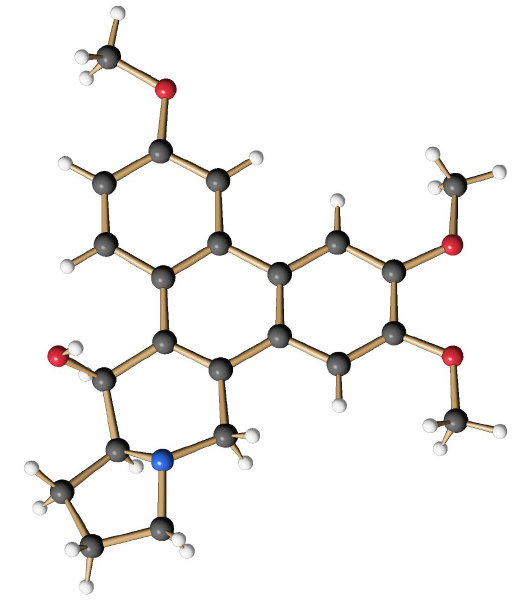
Figure 11. Structure of the synthetic O -methyltylophorinidine ( 1s ) in the crystalline